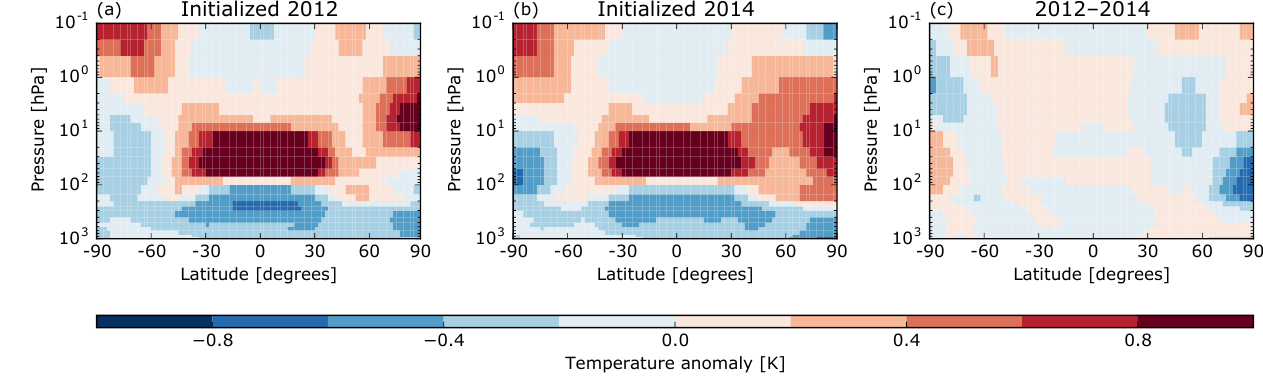
Earth Syst. Dynam., 9, 701–715,